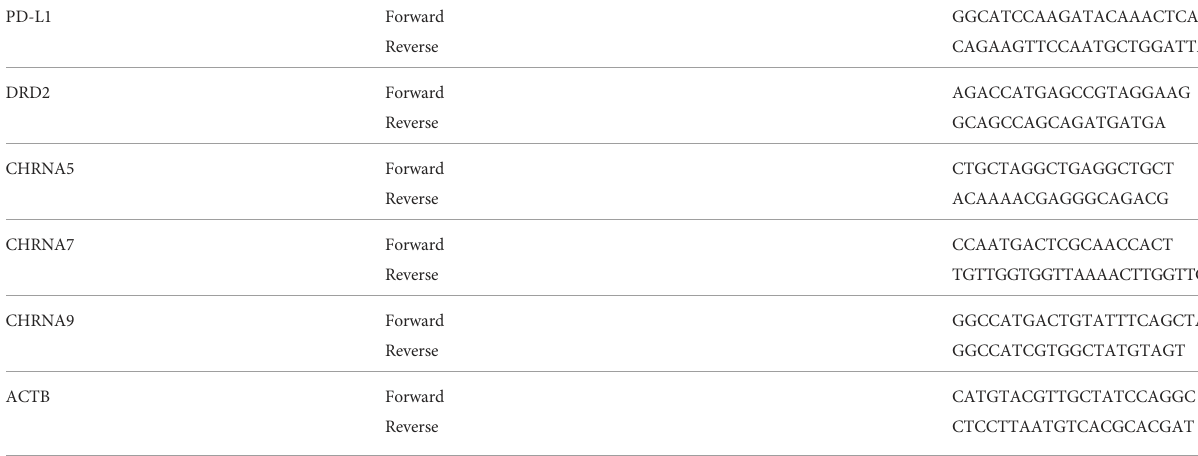
TABLE 2 Primer sequences used in this